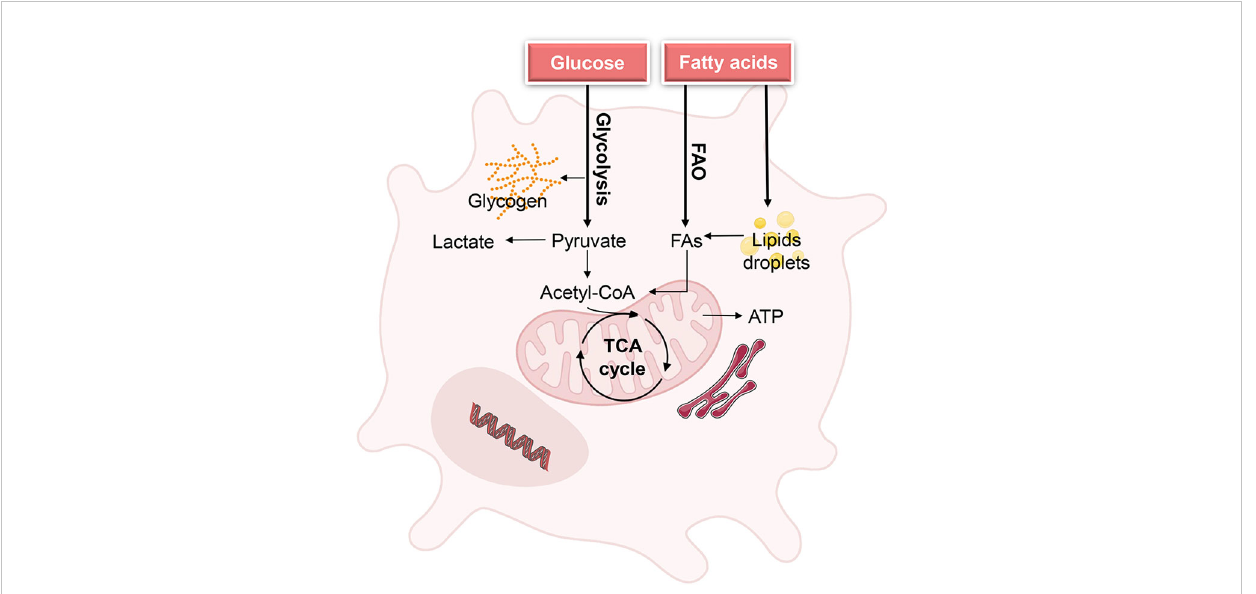
FIGURE 1 Metabolic demands of DCs during homeostasis. Quiescent DCs in peripheral tissues require glucose and fatty acids as fuels to generate energy for cell maintenance and to build up intracellular glycogen and lipid storage. The metabolic state of quiescence is characterized by active oxidative phosphorylation (OXPHOS), which is driven by the tricarboxylic acid (TCA) cycle